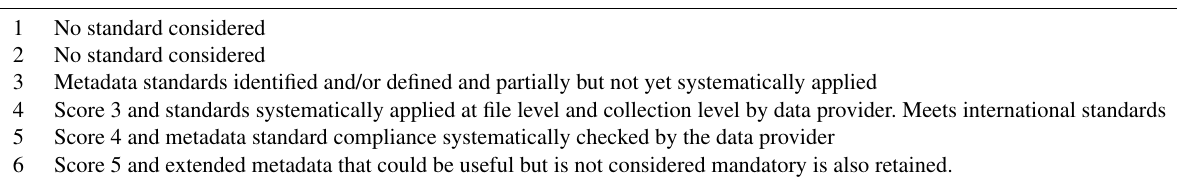
Table 1. The six maturity scores in the metadata subcategory standards. No standard considered No standard considered Metadata standards identified and/or defined and partially but not yet systematically